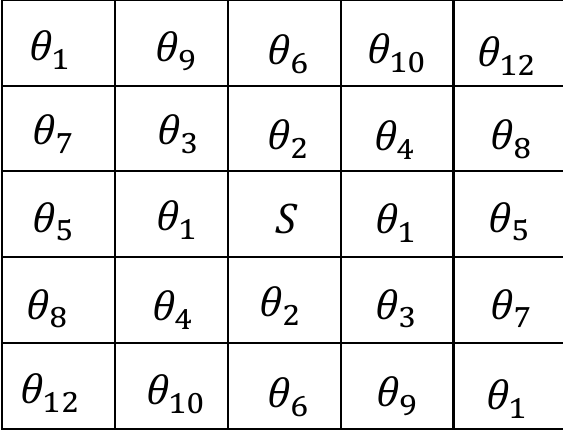
Figure 4. The parameters of the Markov random fields (MRF) model for the first-order neighbor to the fifth-order